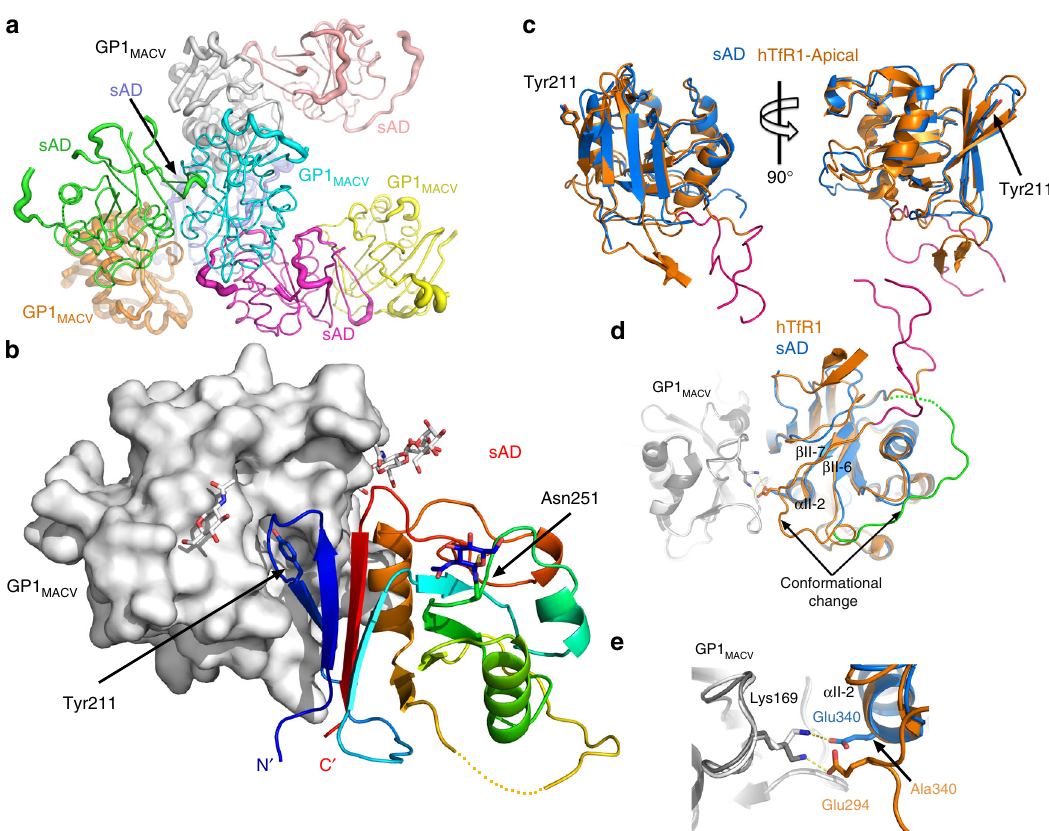
Fig. 3 Isolated sAD retains a similar structure to the apical domain of TfR1. a The asymmetric unit contains four copies of the sAD/GP1 MACV complex. Each of the eight chains is shown using a unique color. The chains are rendered as tubes with radii proportional to the B -factor. The protein pairs in the asymmetric unit differ in quality of the electron density; some have a low B -factors (e.g., green/cyan), while others are less de fi ned and hence have higher B -factor (e.g., purple/orange). Regardless, the sAD/GP1 interface is identical in all pairs. b Crystal structure of sAD in complex with GP1 MACV . The GP1 domain is shown using surface representation (white), and sAD is presented as a ribbon diagram in rainbow colors from the N ′ terminus (blue) to the C ′ terminus (red). N-linked glycans and Tyr211 of sAD are shown using sticks. c The sAD adopts the same overall structure as the apical domain of hTfR1. A ribbon diagram showing the apical domain of hTfR1 (PDB ID: 3KAS) in orange superimposed on sAD, shown in blue. The right view is rotated 90° with respect to the view on the left. Tyr211, a central residue at the interface with GP1, is shown. Residues 301 – 326 of hTfR1, which were omitted in sAD, are colored pink. d A ribbon diagram showing the structure of the complex between sAD and GP1 MACV , in blue and white, respectively, superimposed on the hTfR1/GP1 MACV complex (PDB ID: 3KAS), colored orange and gray, respectively. The long loop that connects strands β II-6 and β II-7 changes position in sAD compared to hTfR1 and is highlighted in green (sAD). This loop in hTfR1 originally included residues 301 – 326 (pink), which were eliminated from sAD. e Similar superimposition as in d , showing the charge – charge interaction between GP1 MACV and sAD or hTfR1. The negatively charged Glu294 of hTfR1 forms a salt bridge with Lys169 from GP1. In the case of sAD, Glu340 from α II-2, which replaces an alanine residue of hTfR1, projects in the same direction as Glu294 of hTfR1. This Glu340 of sAD forms a similar salt bridge with Lys169 of GP1 MACV